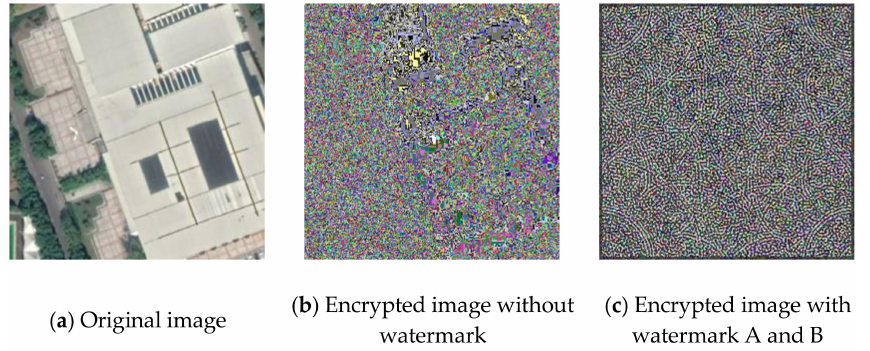
Figure 7. Example of Encryption